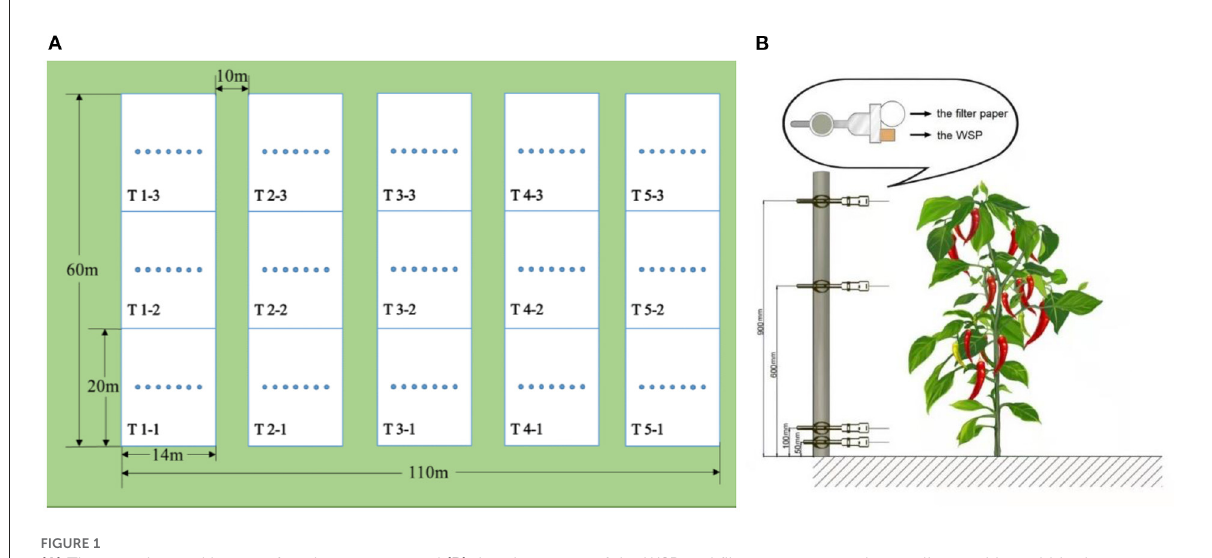
FIGURE1 (A) The experimental layout of each treatment and (B) the placement of the WSP and filter papers at each sampling position within the processing